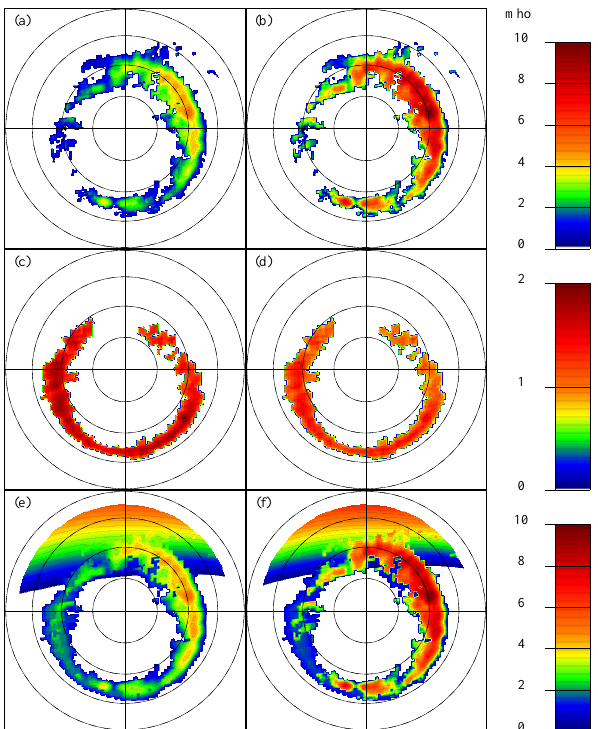
Plate 3. Conductance maps for 23 December 2000, 21:04UT (same as Plate 2) using constant particle mean energy over the entire au- roral region. < E > el =6.4keV and < E > pr =8keV. Circles show 50 ◦ , 60 ◦ , 70 ◦ and 80 ◦ MLAT. The local midnight is located